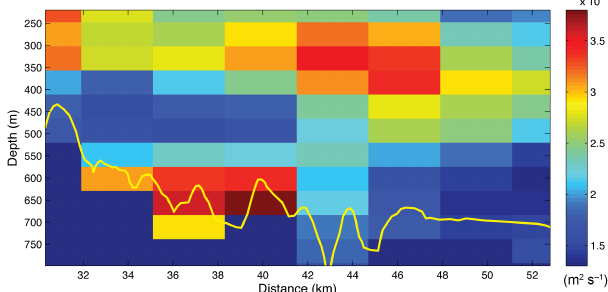
Figure 9. Turbulent diffusivity map created by displacement spectra calculated over windows 3.2km wide by 50m deep. At this rough scale, elevated turbulent diffusivity is observed around the rough bathymetry as well as above the lee wave generation sites.